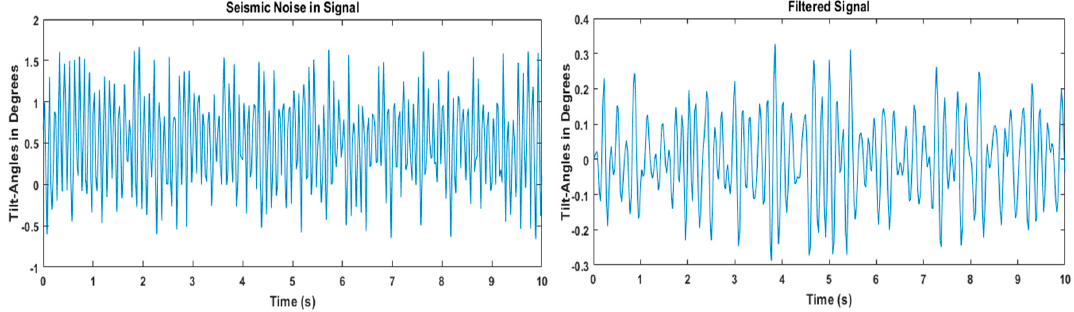
Figure 4. Seismic noise filtration and new refined signal.